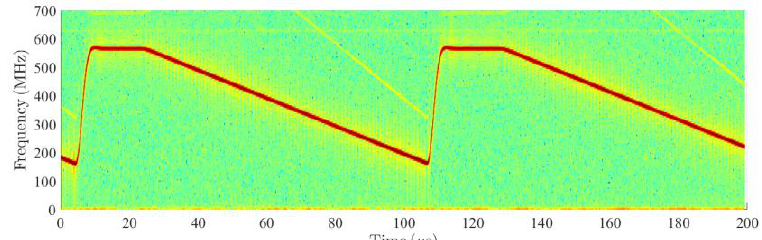
Figure 10. Measured spectrogram of received and down-converted signal from the MRR1 radar sensor